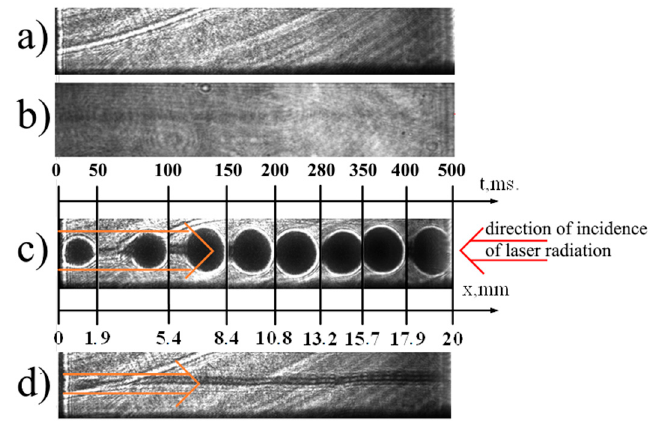
Figure 11. The results of processing digital holograms during the breakdown of a ZGP single crystal by laser radiation: ( a ) is the sample before optical breakdown, ( b ) is the darkening region of the laser radiation propagation channel in the pre-breakdown region of parameters, ( c ) is the timelapse of the movement process of the “luminescent cloud”, ( d ) is the sample with a track from optical breakdown. The red pointer indicates the propagation direction of the incident beam at 2.09 µm. The yellow pointers indicate the propagation direction of the glowing ball of the damaged area.